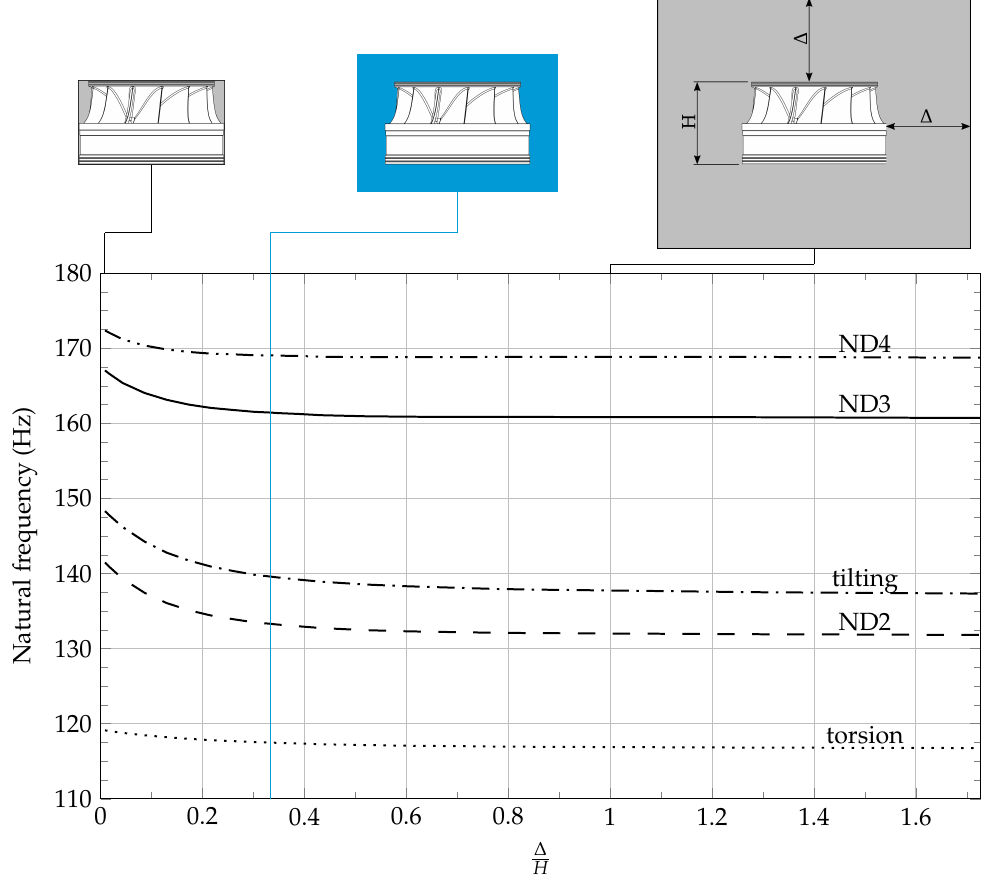
Figure 11. Influence of the size of water